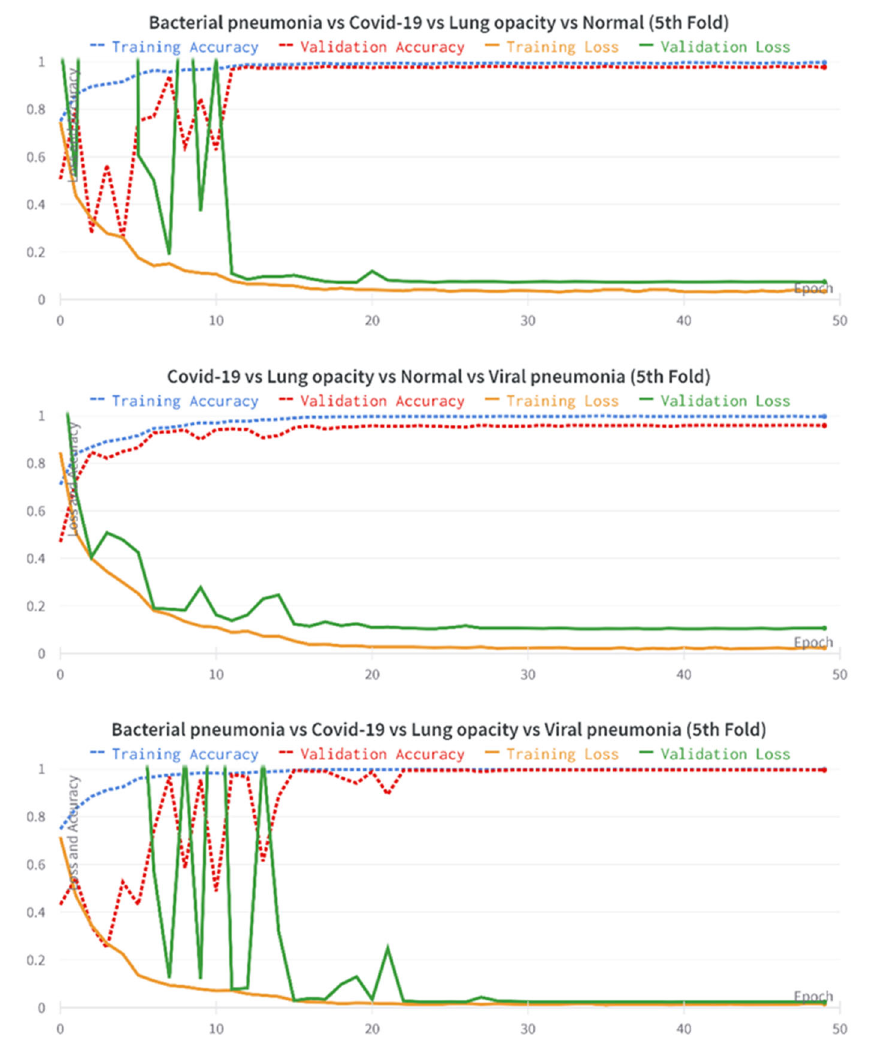
Figure 3. Accuracy and loss plots over 50 training epochs for 4-class experiments (5th fold).